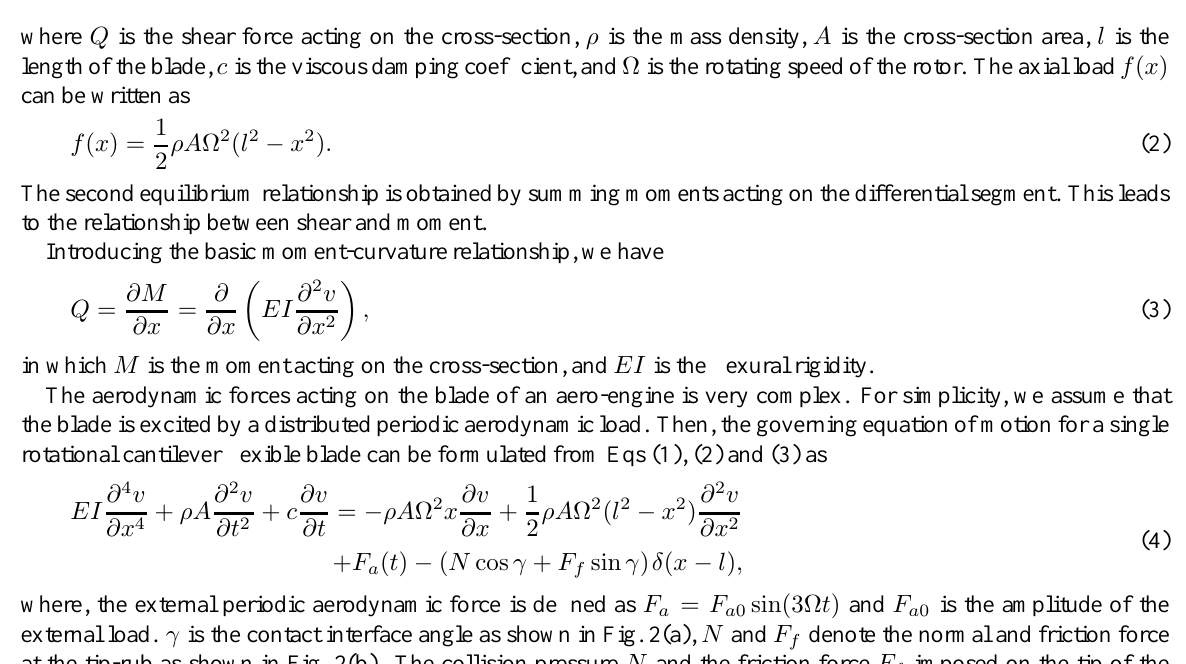
Fig. 1. Rotating blade with tips of an aero-engine